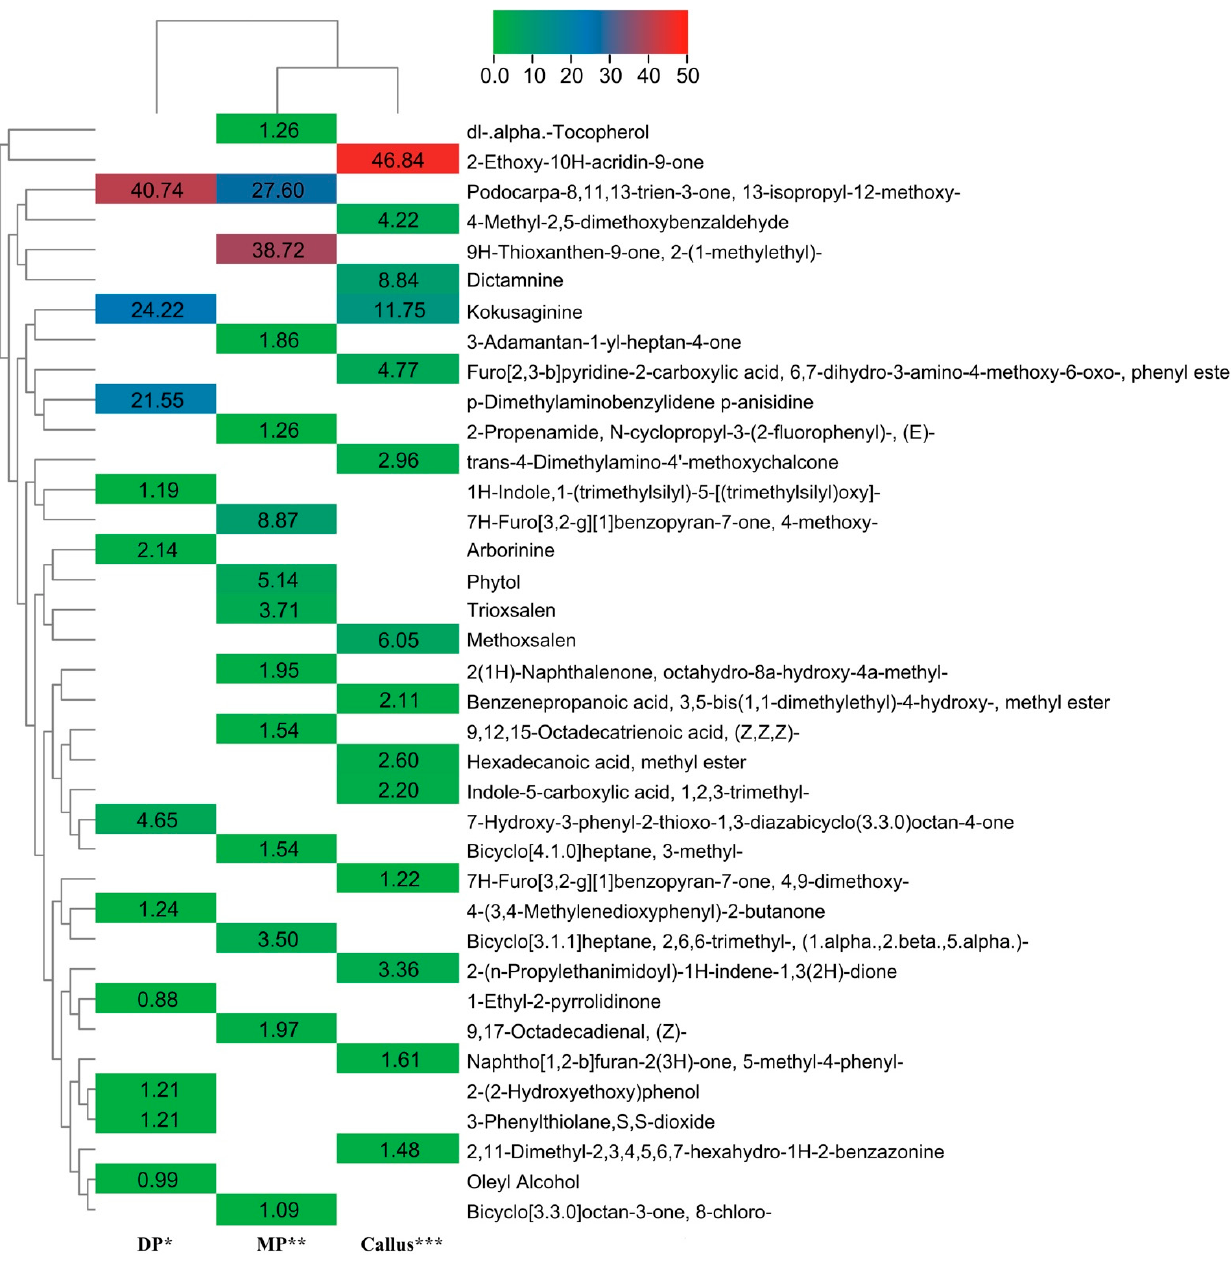
Figure 3. Cluster heatmap analysis based on the relative levels of phytochemicals measured by GC– MS in R. chalepensis. The magnitude and direction of the correlations are shown by the colors in the matrix boxes. * DP = donor plant growing in soil in the botanical garden; ** MP = ex-vitro-established micropropagated plants; *** callus = callus obtained on MS + 2,4-D (10 μ M) + BA(1.0 μ M).